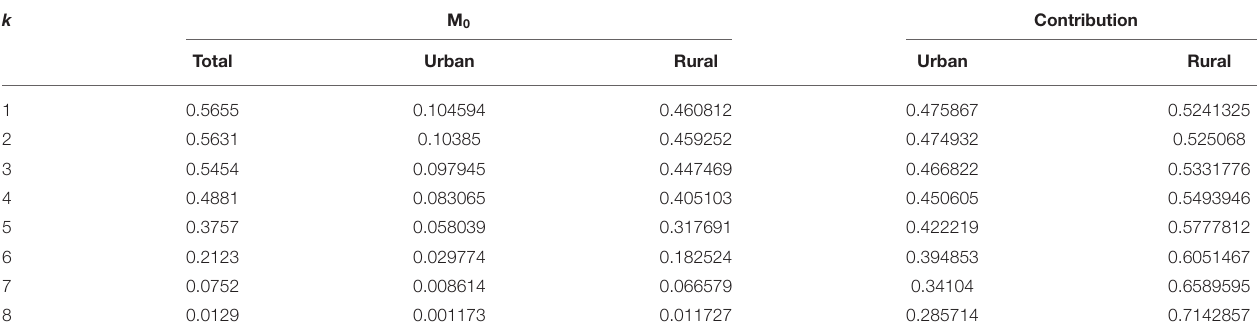
TABLE 6 | Multidimensional disability index (M 0 ) and contribution rate under different k values were broken down by urban and rural areas.